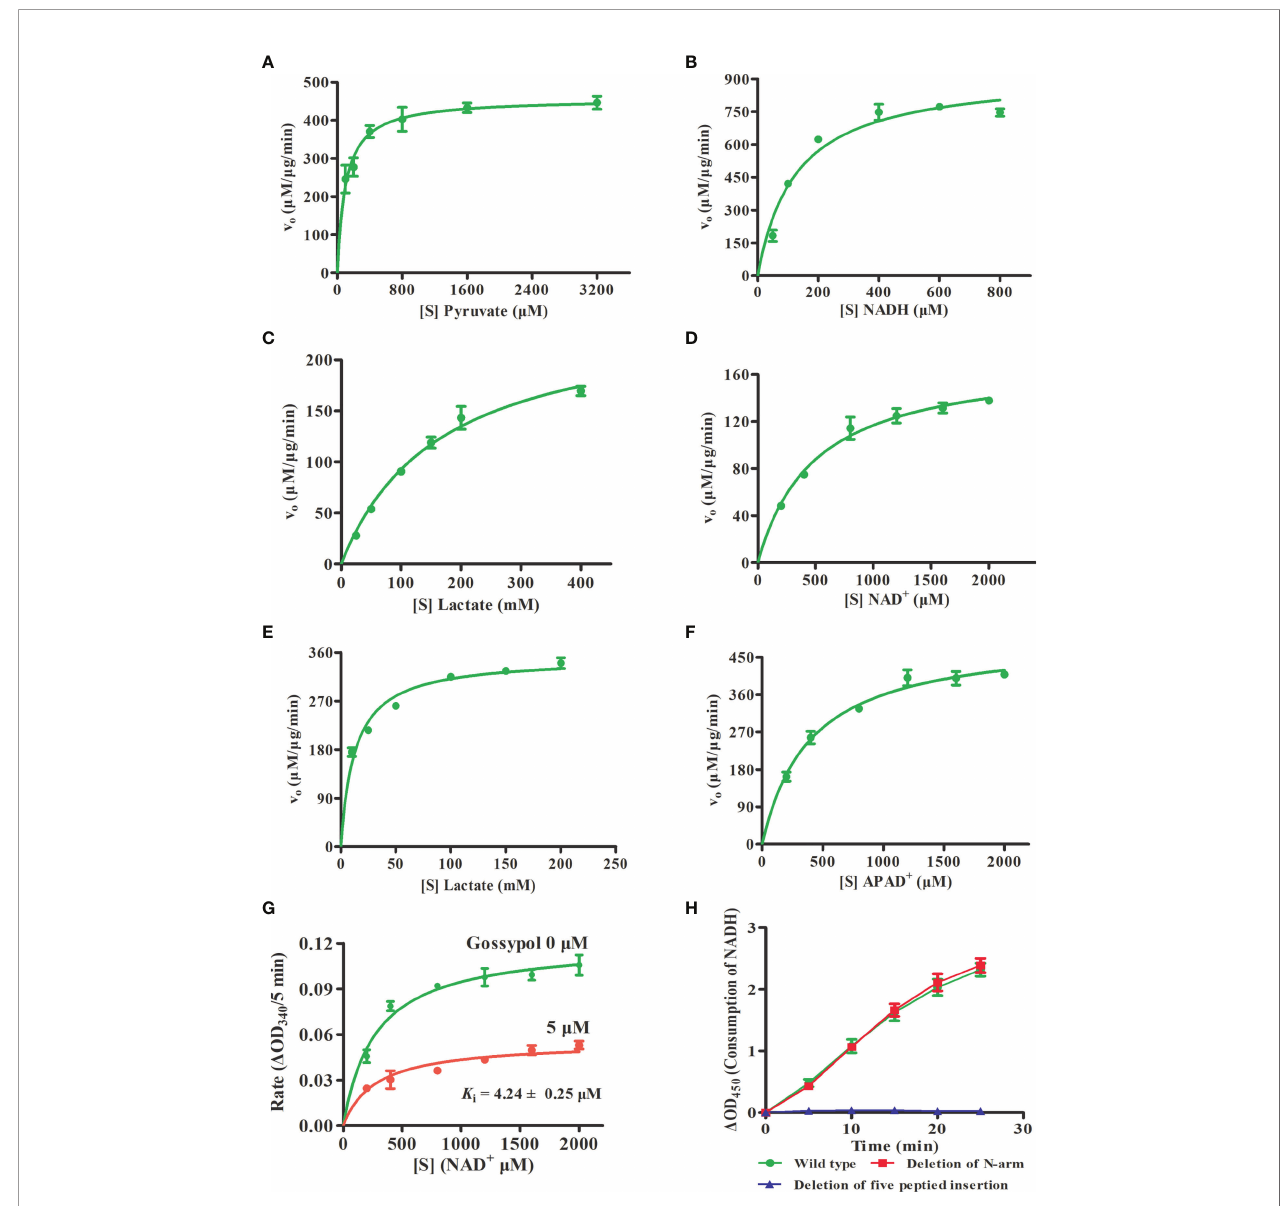
FIGURE 3 | Enzyme kinetics and inhibition constant. (A, B) Michaelis-Menten Kinetics for the forward reaction of rBoLDH. Variations of rBoLDH activity with concentration of pyruvate and NADH. (C, D) Michaelis-Menten Kinetics for the reverse reaction of rBoLDH. Variations of rBoLDH activity with concentration of lactate and NAD + . (E, F) Michaelis-Menten Kinetics for the reverse reaction of rBoLDH. Variations of rBoLDH activity with concentration of lactate and APAD + . (G) Michaelis-Menten- based kinetics of inhibition of rBoLDH activity in the presence of 5 µM gossypol. The changes of density of NAD + were monitored at OD 340 . (H) Enzyme activity test for two variants of rBoLDH. The forward assays were performed at 25°C in pH 7.5 50 mM Tris-HCl buffer, containing 50 ng rBoLDH, 2 mM pyruvate and 0.8 mM NADH. S, substrate as indicated; V o , initial velocity. The error bar represents mean ± SD (n=3), and Non-linear regressions and XY graph were drawn with